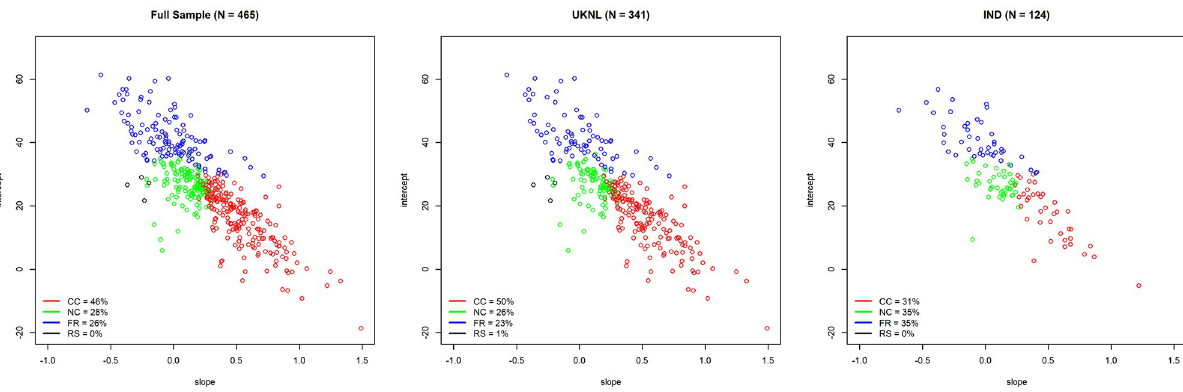
Fig 6. Plot of intercept and slope of LCP scores—Types by